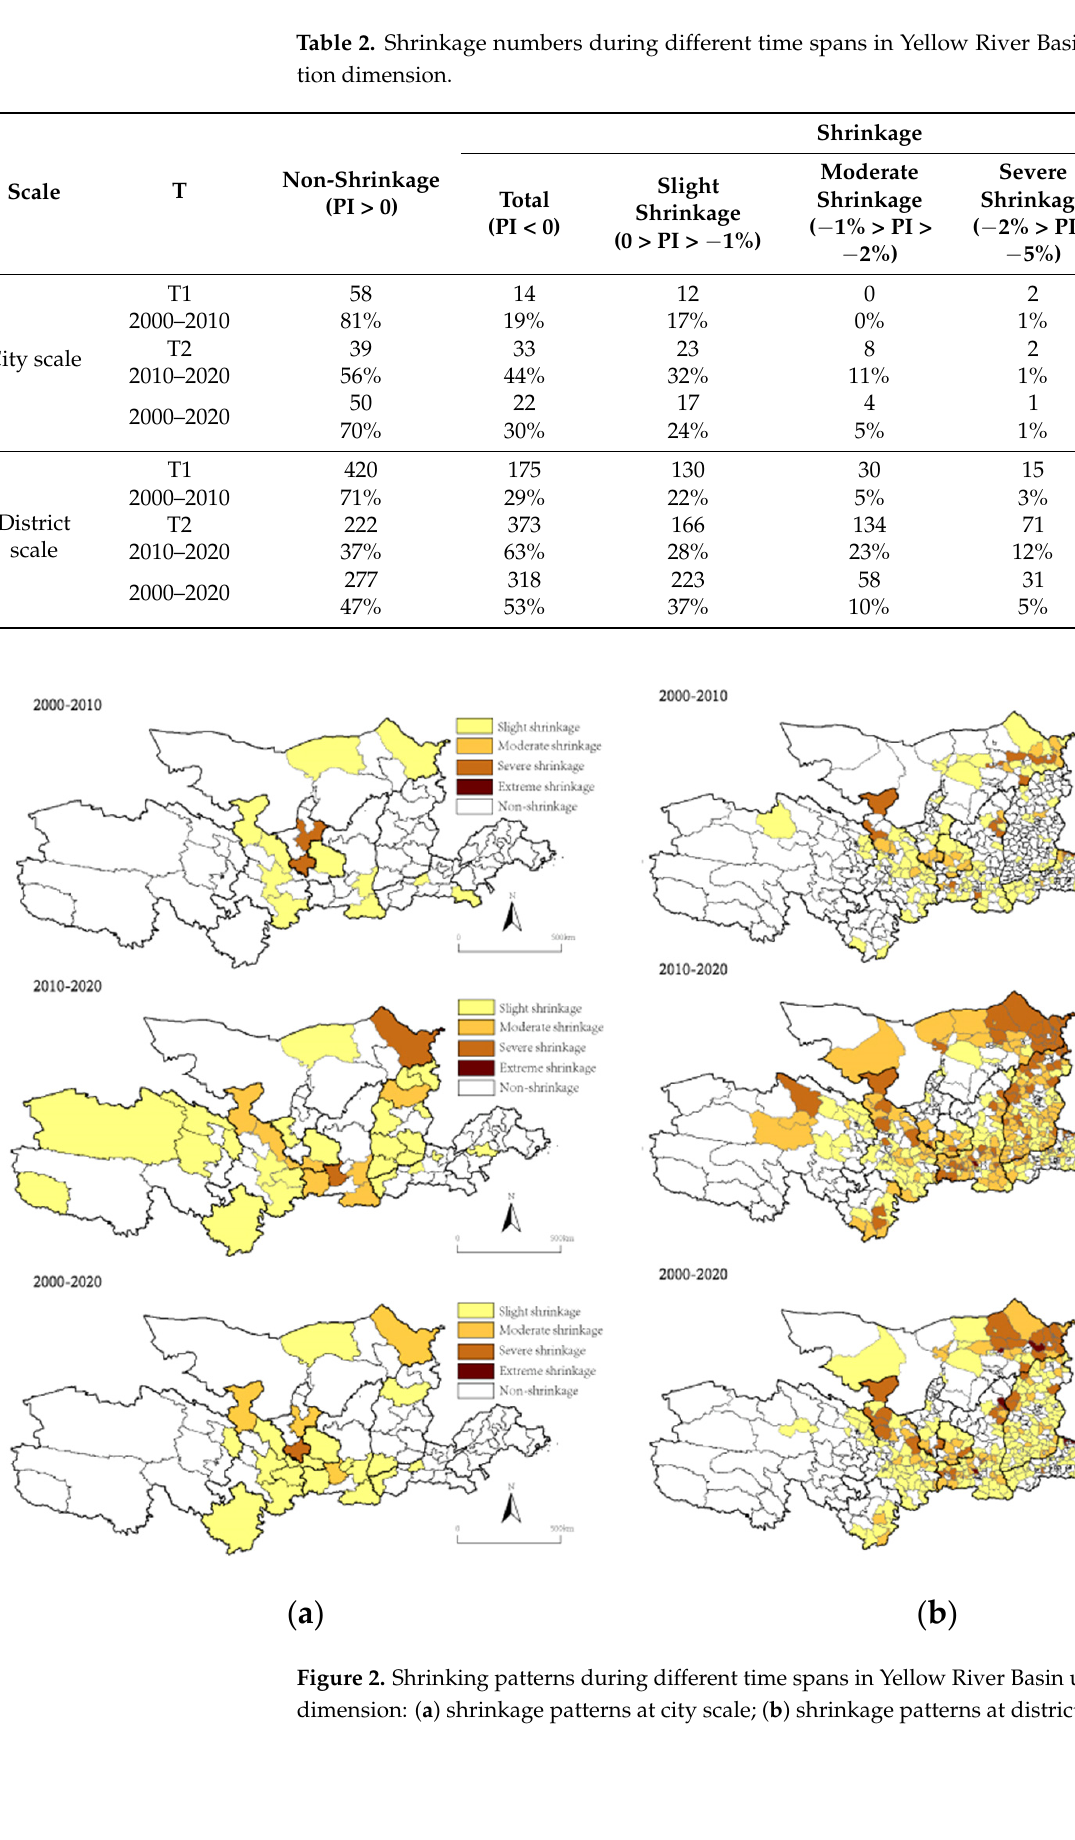
Population loss and economic recession are two of the most commonly used indica- tors to identify shrinking cities. [36] Studies have shown that the brightness of the light in an area is positively correlated with the level of local economic development. In addition, data can also estimate the area illuminated by lights in a city at night by using light spots [37]. Therefore, the “triple attribute” of nighttime light data makes it possible to incorpo- rate urban population, land, and economic factors into urban-scale measurements at the same time. Based on the characteristics of long-term time-series NL data and the related research, we define shrinking cities as continuously shrinking cities: cities experiencing a continuous loss of brightness (i.e., annual TDN reductions for three consecutive years), or frequently shrinking cities (i.e., cities that have been shrinking for at least one-third of a